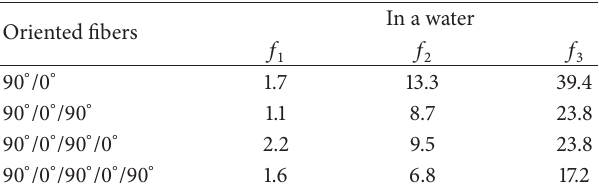
Table 4: Natural frequencies 𝑓 (Hz) of the fin in the case of 90 ∘ /0 ∘ /90 ∘ /0 ∘ /90 ∘